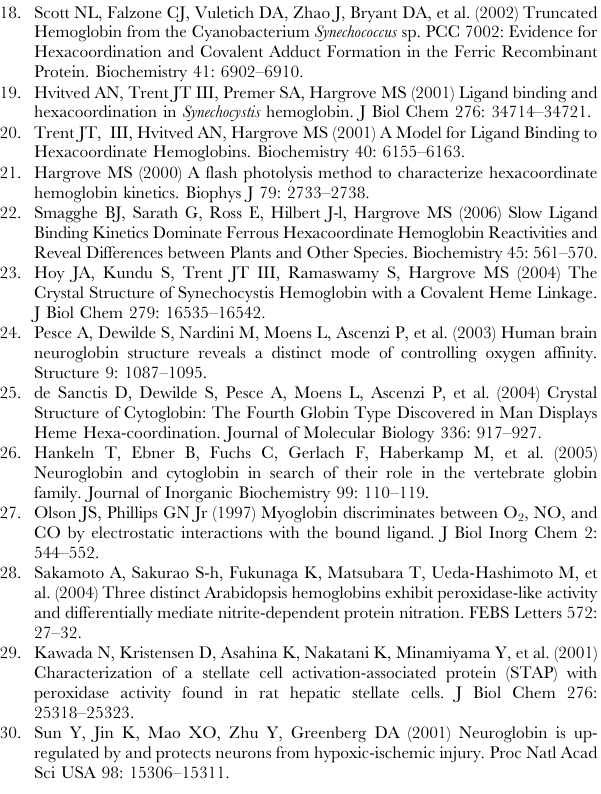
Relative Expression Averaged maximum absorbance (CO difference spectrum